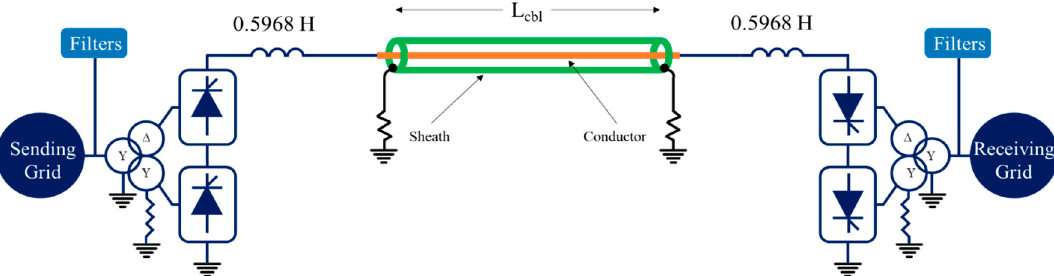
Figure 1. A schematic of Line Commutated Converter (LCC) High Voltage DC (HVDC) transmission system and a cable section with sheath grounded at the terminals.